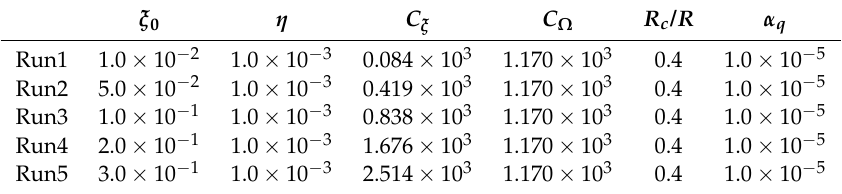
Table 2. Parameters of the fluid model in geometrized units ( c = G = M (cid:12) = 1).